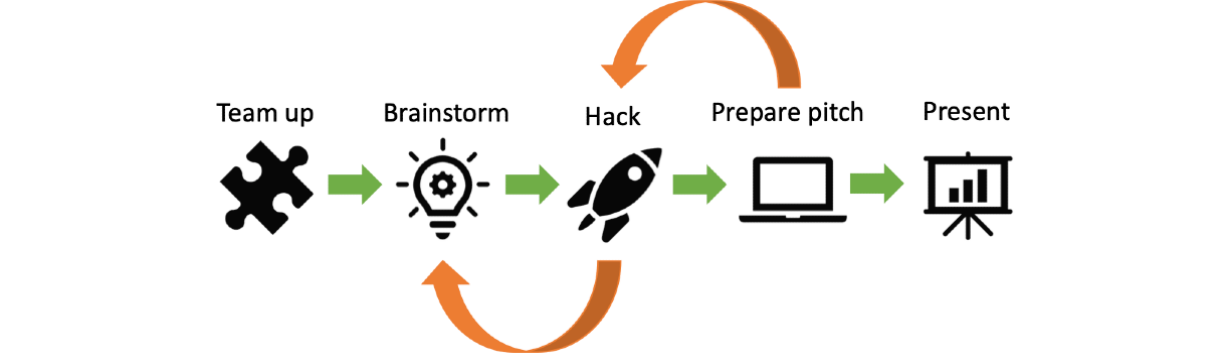
Figure 1. Hackathon flow, from teaming up to demonstration of the project pitch and working prototype (green arrows). In contrast to our expectations, teams often jumped back and forth between brainstorming, hacking, and preparing the pitch (orange arrows).